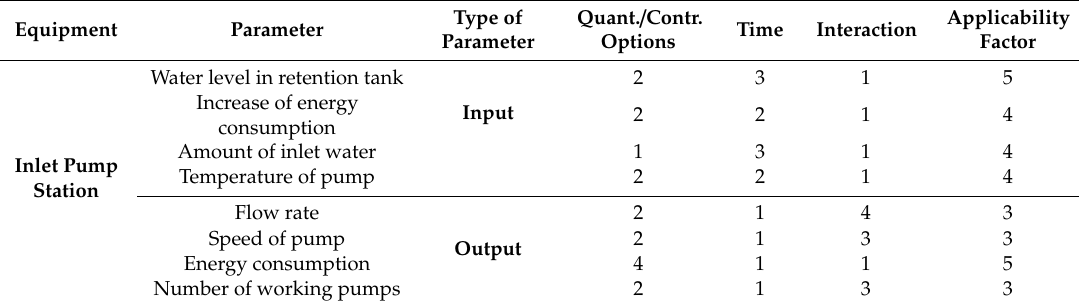
Table 7. Evaluation parameters of the inlet pump